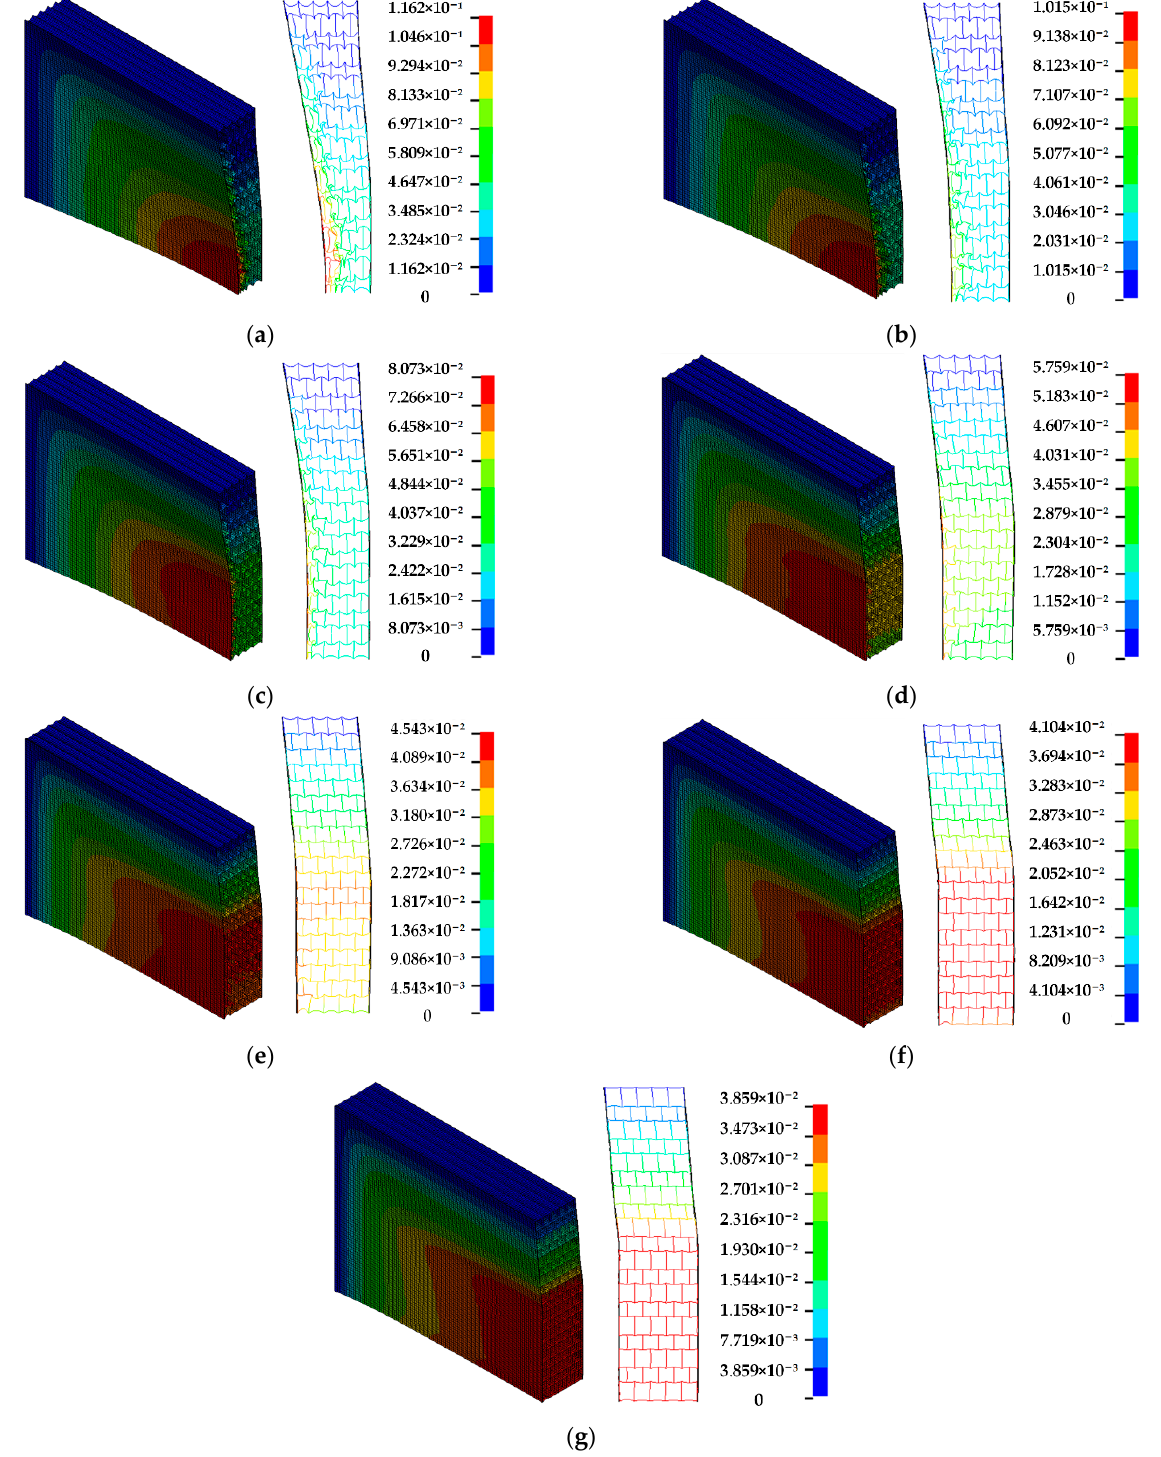
Figure 15. Deformation of different concave angles. (a) 15°; (b) 25°; (c) 35°; (d) 45°; (e) 55°; (f) 65°; (g) 75°.